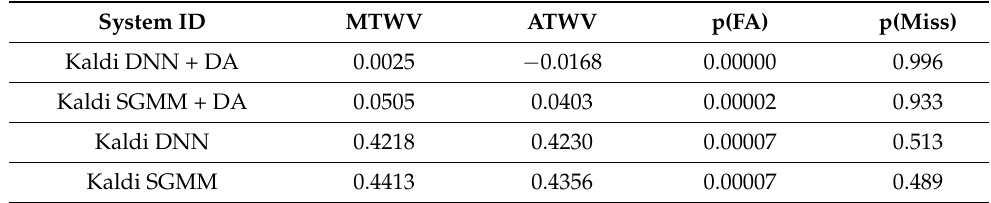
Table 10. System results of the STD task for MAVIR test